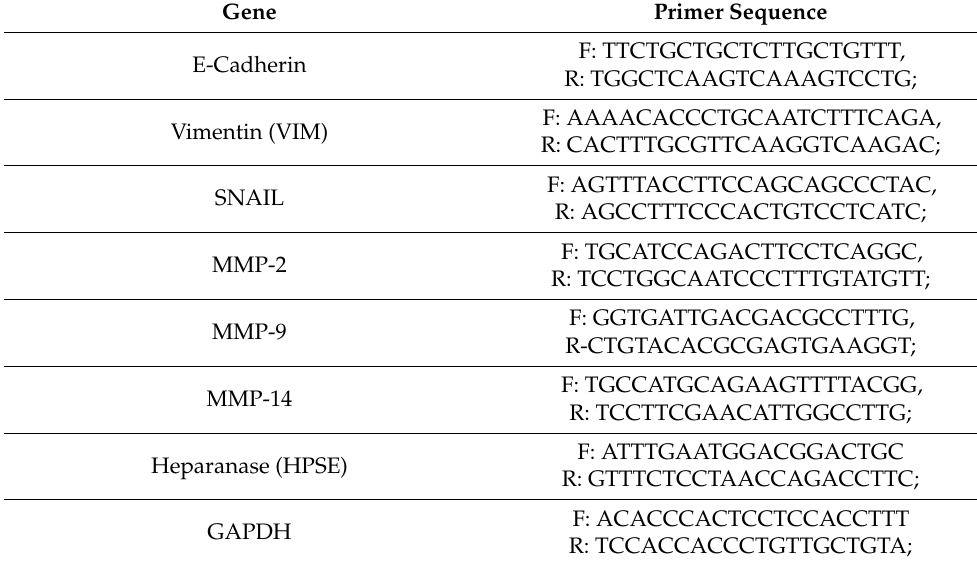
Table 1. List of real-time qPCR primers used in this